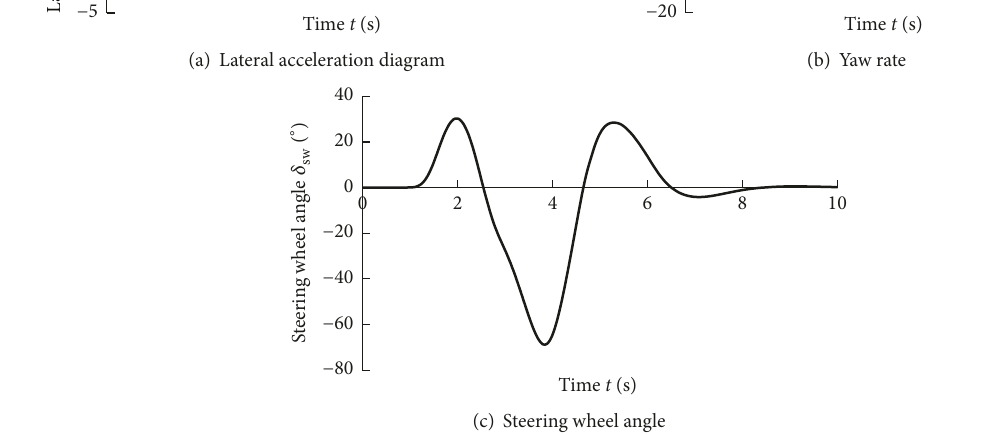
Figure 4: Vehicle status ( 𝜇 = 0.45 ).